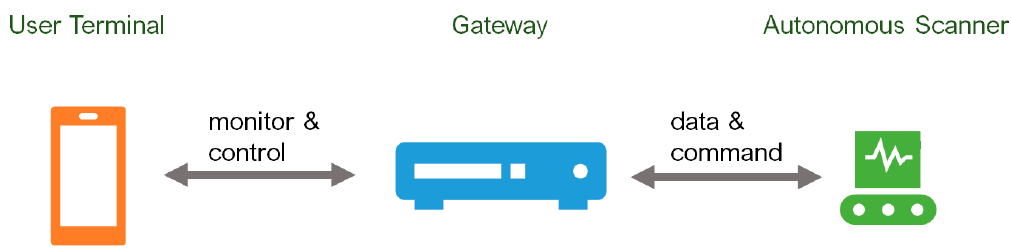
Figure 1. Conceptual architecture of proposed autonomous scanning system. It is composed of three main parts: a user terminal, a gateway, and an autonomous scanner.